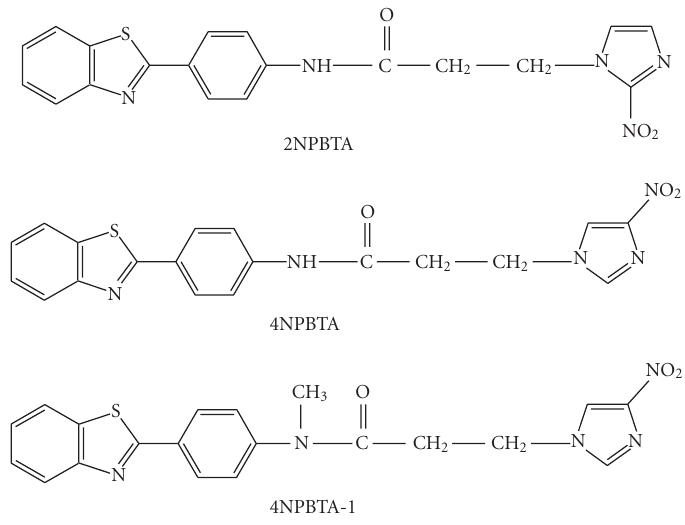
Figure 1: Structures of [ 131 I]2NPBTA, [ 131 I]4NPBTA, and [ 131